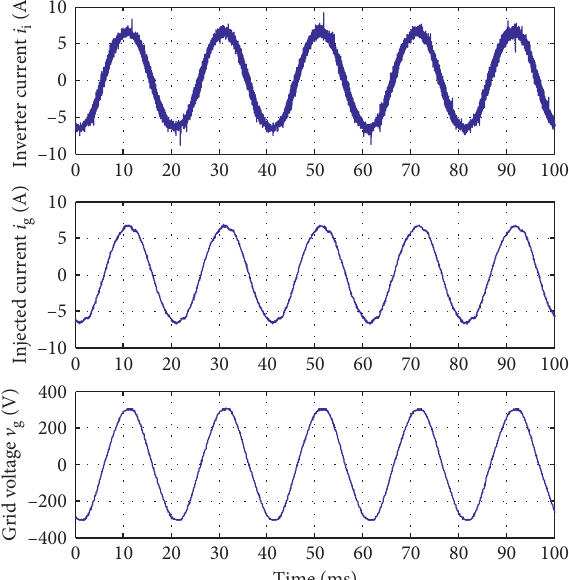
Figure 14: Experimental result at full load